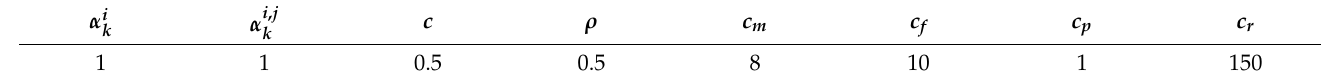
Table 1. Parameter